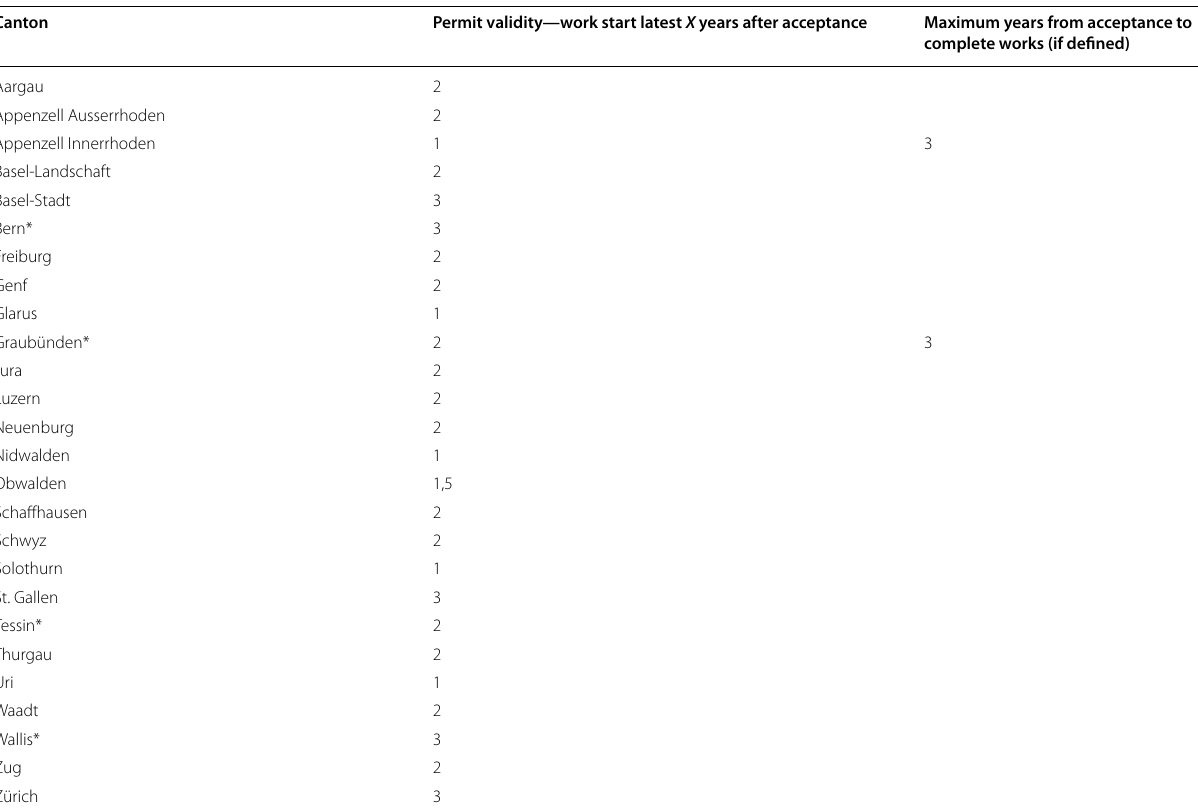
Table 3 Construction permits validity according to cantonal legislation